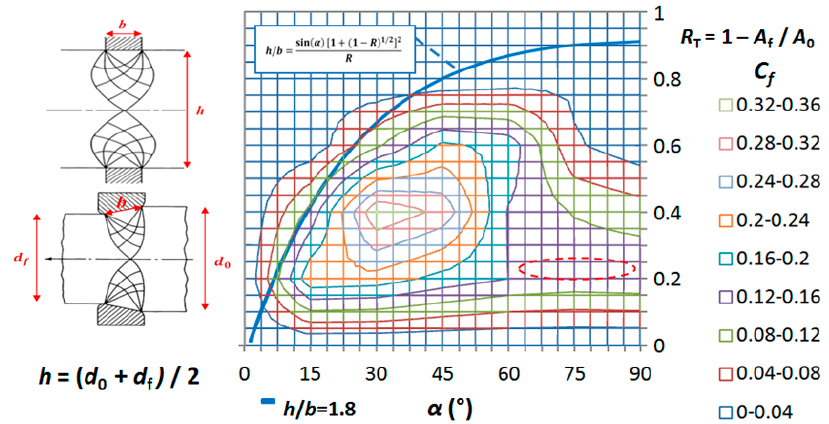
Figure 9. Central damage factors ( C f ) map in single-pass extrusion of dual-phase steel DP800 for m = 0.08 and theoretical limit of central burst appearance (blue curve) according to [21].